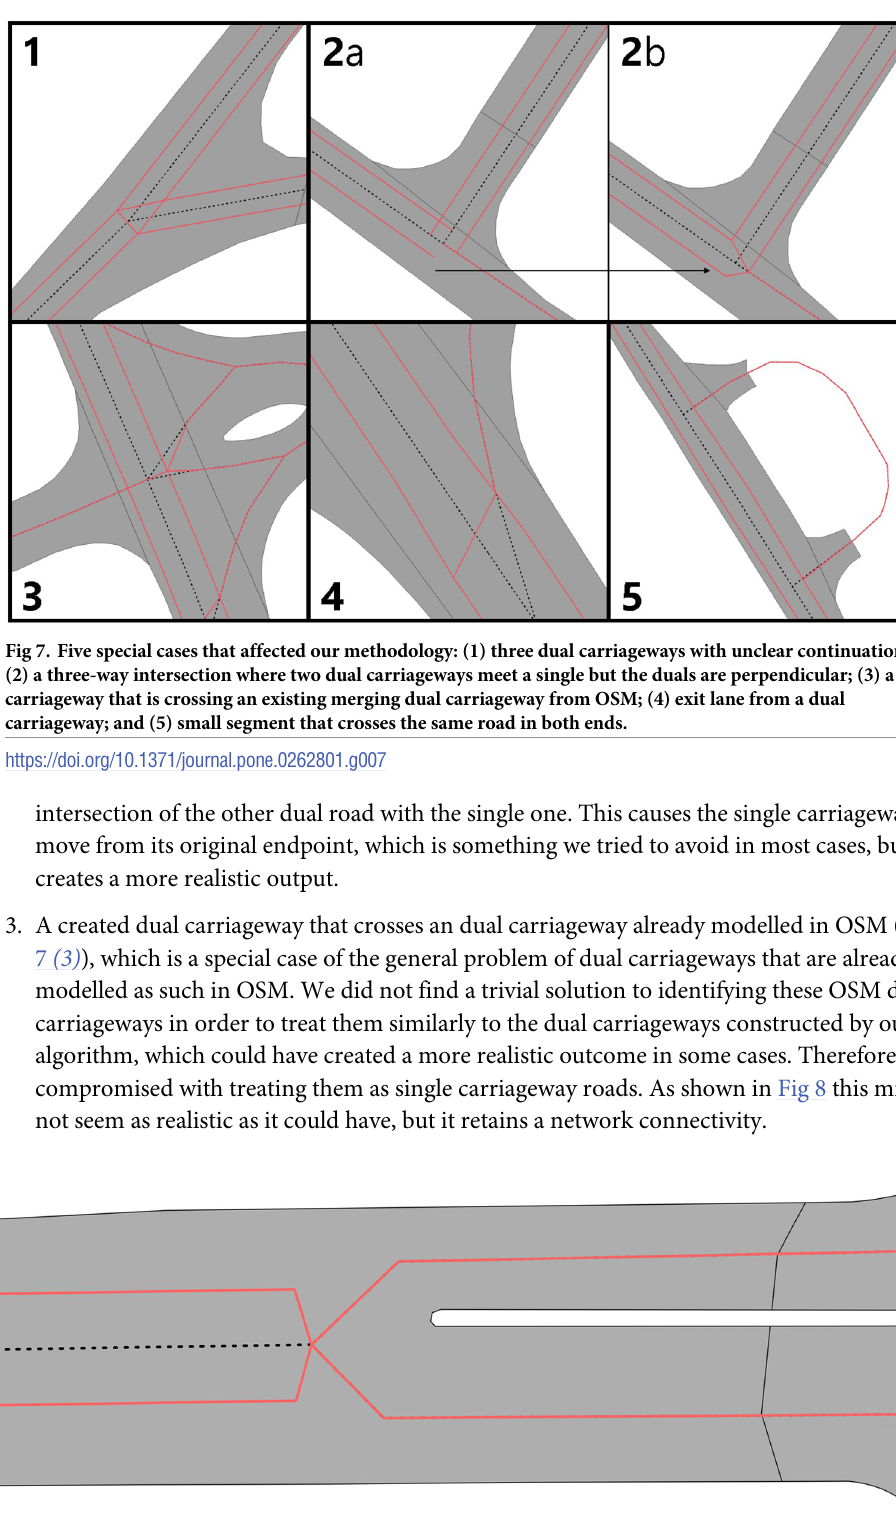
PLOS ONE | https://doi.org/10.1371/journal.pone.0262801 February 22,